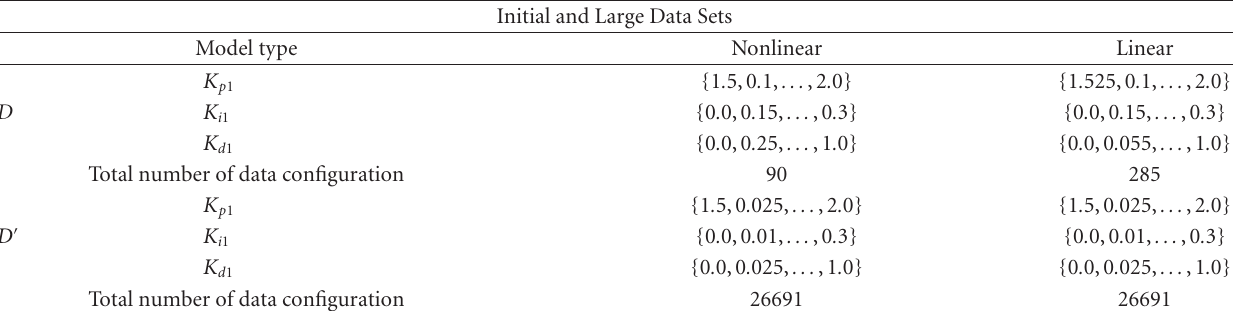
Table 2: Initial and large data